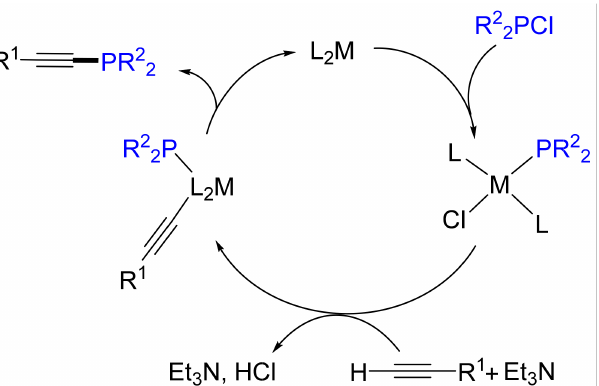
Figure 4. Proposed mechanism for the nickel- and palladium-catalyzed C(sp)-P cross-coupling (M = Ni, Pd).